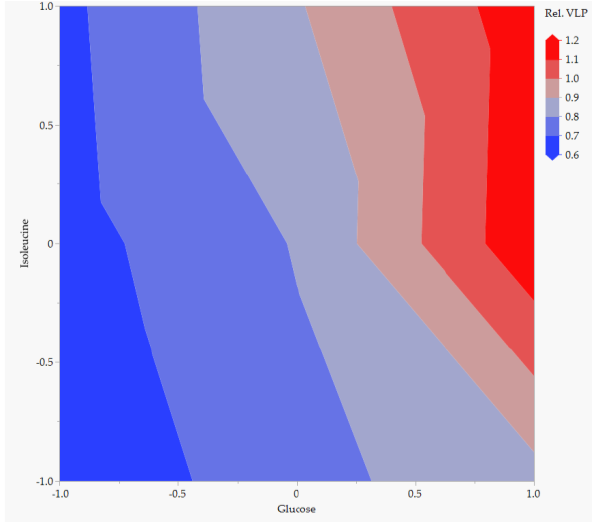
Figure 8. Contour plots for simulations of the normalized HIV-Gag VLP concentration depending on the Isoleucine and Glucose concentration (both depicted as normalized values).